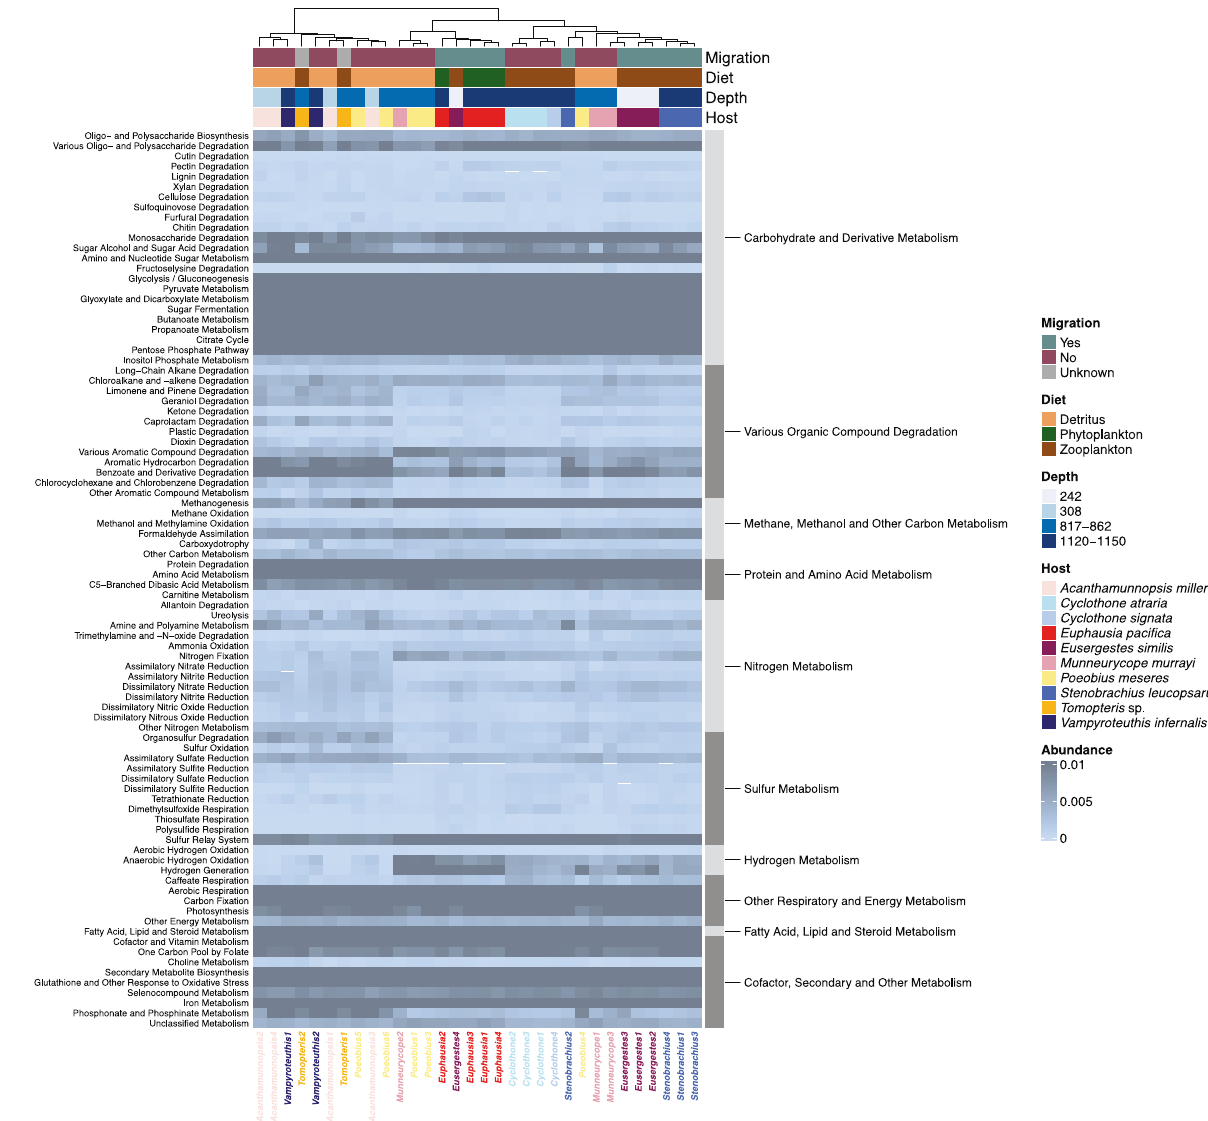
Fig. 4 Proportional abundance heatmap based on Euclidean distance for metabolic functions predicted from gene-level shotgun metagenomic data. Samples were clustered with the complete linkage method, where similarity between clusters is determined by the distance between the most dissimilar members of the respective clusters. Functional potential shows only weak associations with diel vertical migration status and diet, but is partly linked to host taxon and depth as indicated by hierarchical clustering between samples and PERMANOVAs (Table 4). Note that genes might belong to multiple metabolic